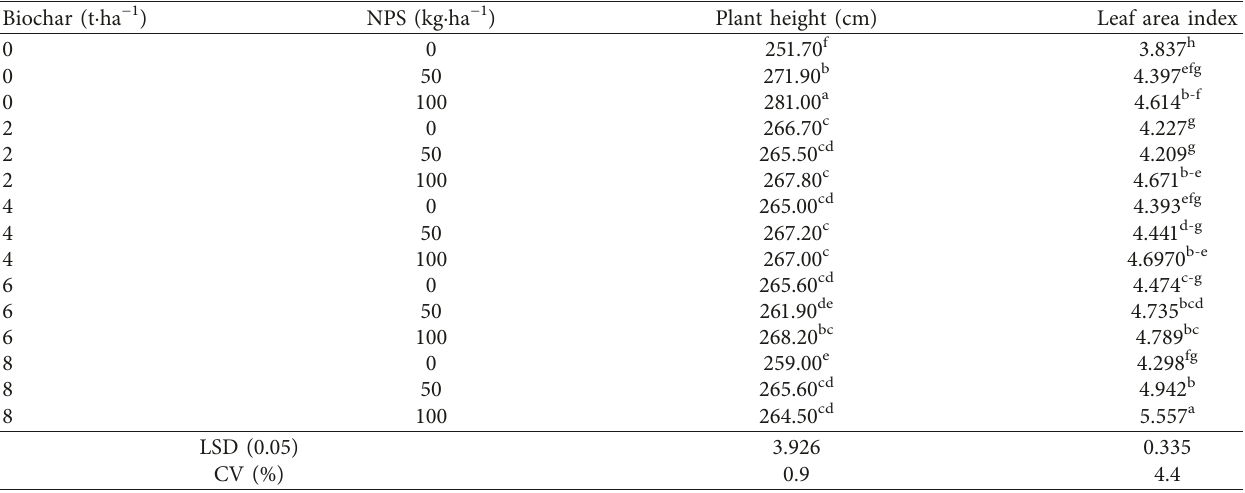
Table 4: Interaction effect of biochar levels and inorganic NPS fertilizer rates on plant height (cm) and leaf area index (LAI) of maize in Guto Gida, Western Ethiopia.